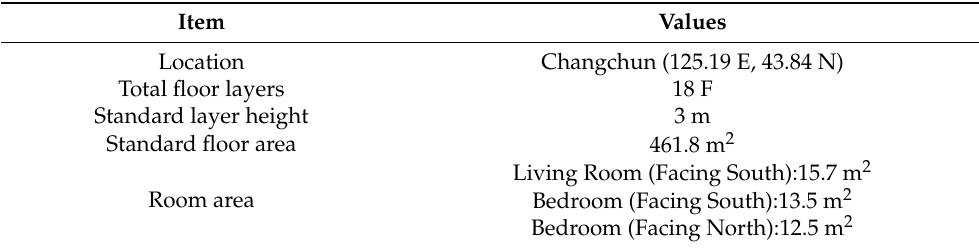
Table 2. Details of the residential